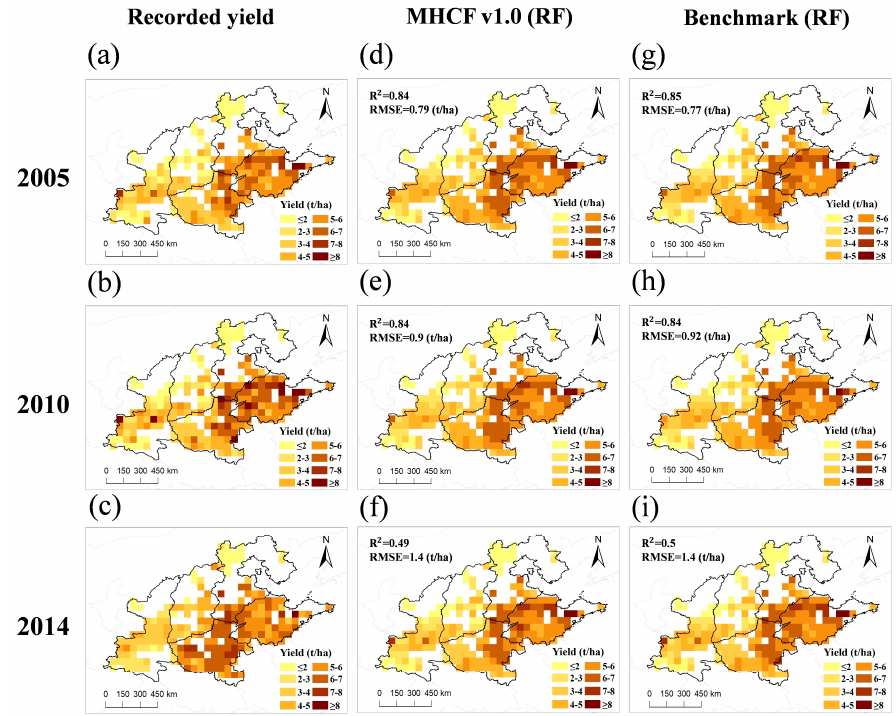
Figure 8. Spatial patterns of the yield predicted with RF (2005, 2010 and 2014). ( a – c ) the recorded yield; ( d – f ) the yield predicted by MHCF v1.0; ( g – i ) the yield predicted by the Benchmark model.